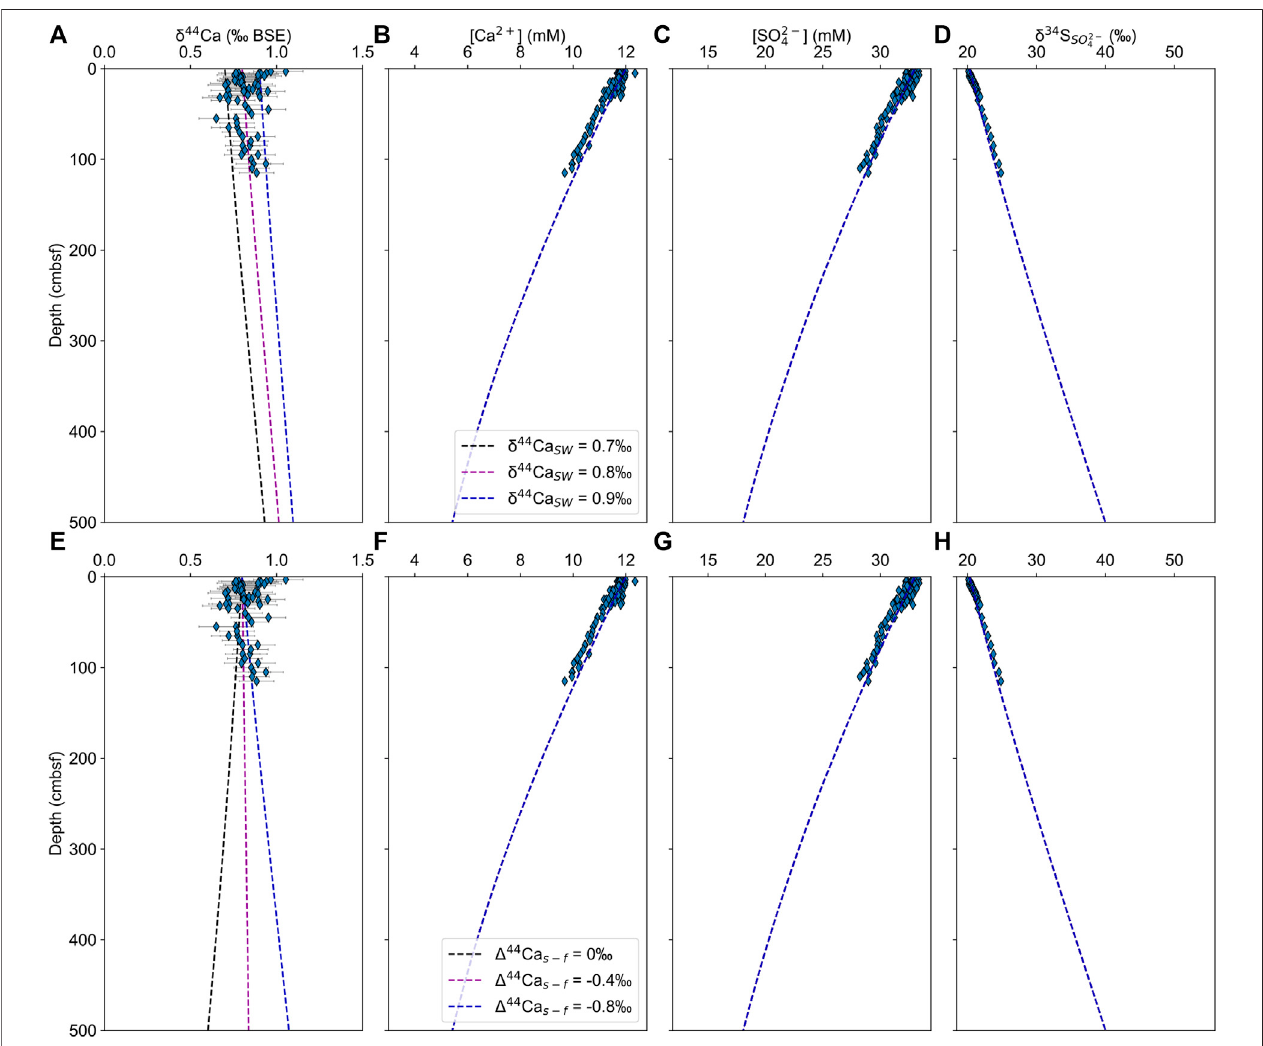
FIGURE6| CrunchTope reactive transportmodeling resultsfor pore fl uid δ 44 Ca (A,E) , [Ca 2+ ] (B,F) ,[SO 42 – ] (C,G) , and δ 34 S (D,H) .The top row (A – D) includes the results of runs with varying seawater calcium isotope composition ( δ 44 Ca SW (cid:1) 0.7 – 0.9 ‰ ) and a constant calcium isotopefractionation factor of α (cid:1) 0.9992. The bottom row (E – H) includes the results of runs with a constant δ 44 Ca SW and a varying calcium isotope fractionation factor ( α (cid:1) 0.9992 – 1, Δ 44 Ca s-f (cid:1) – 0.8 – 0 ‰ ).